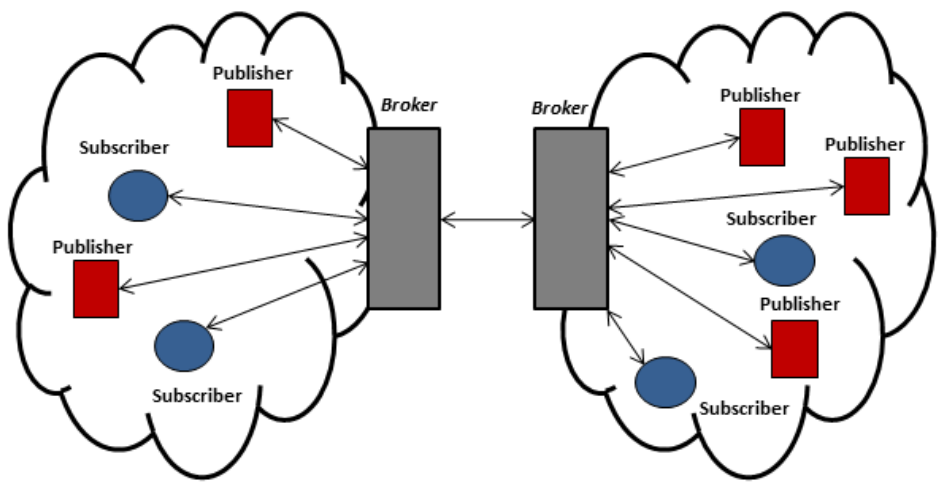
Figure 16. General View of Single-Hop Extended